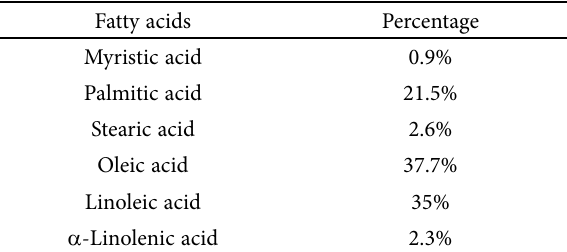
Table 1. Fatty acids compositions of rice bran